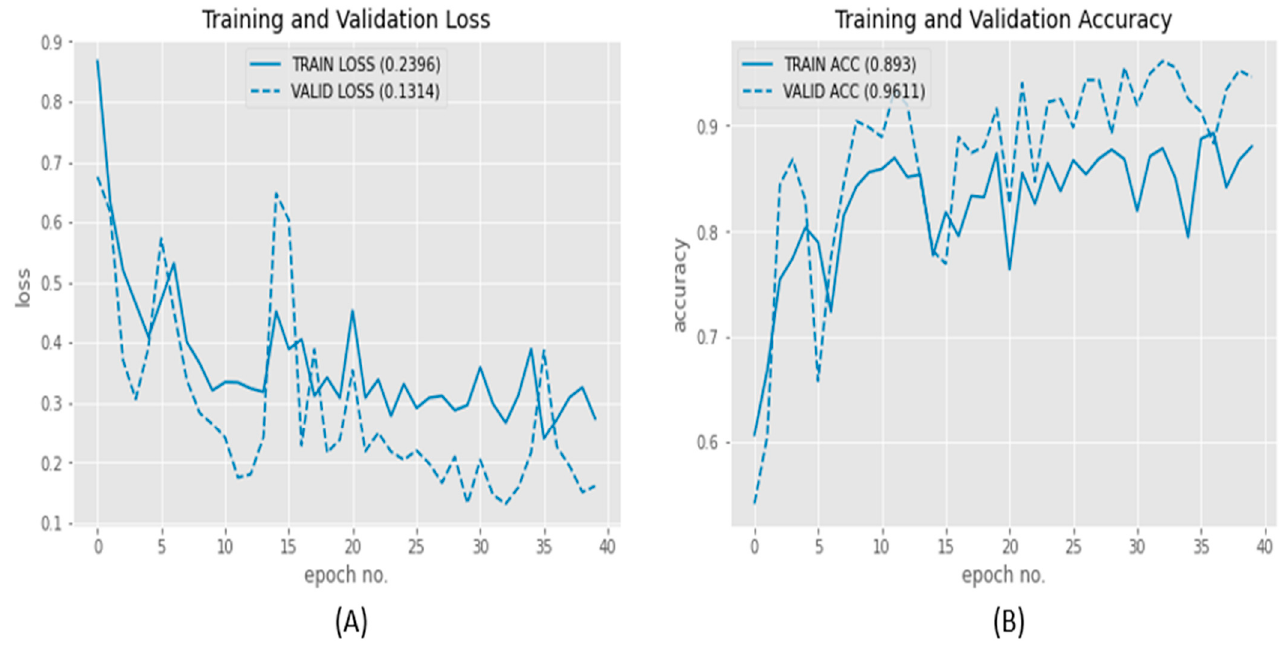
Figure 11. Generic-augmented data performance ( A ) loss ( B ) accuracy comparison.